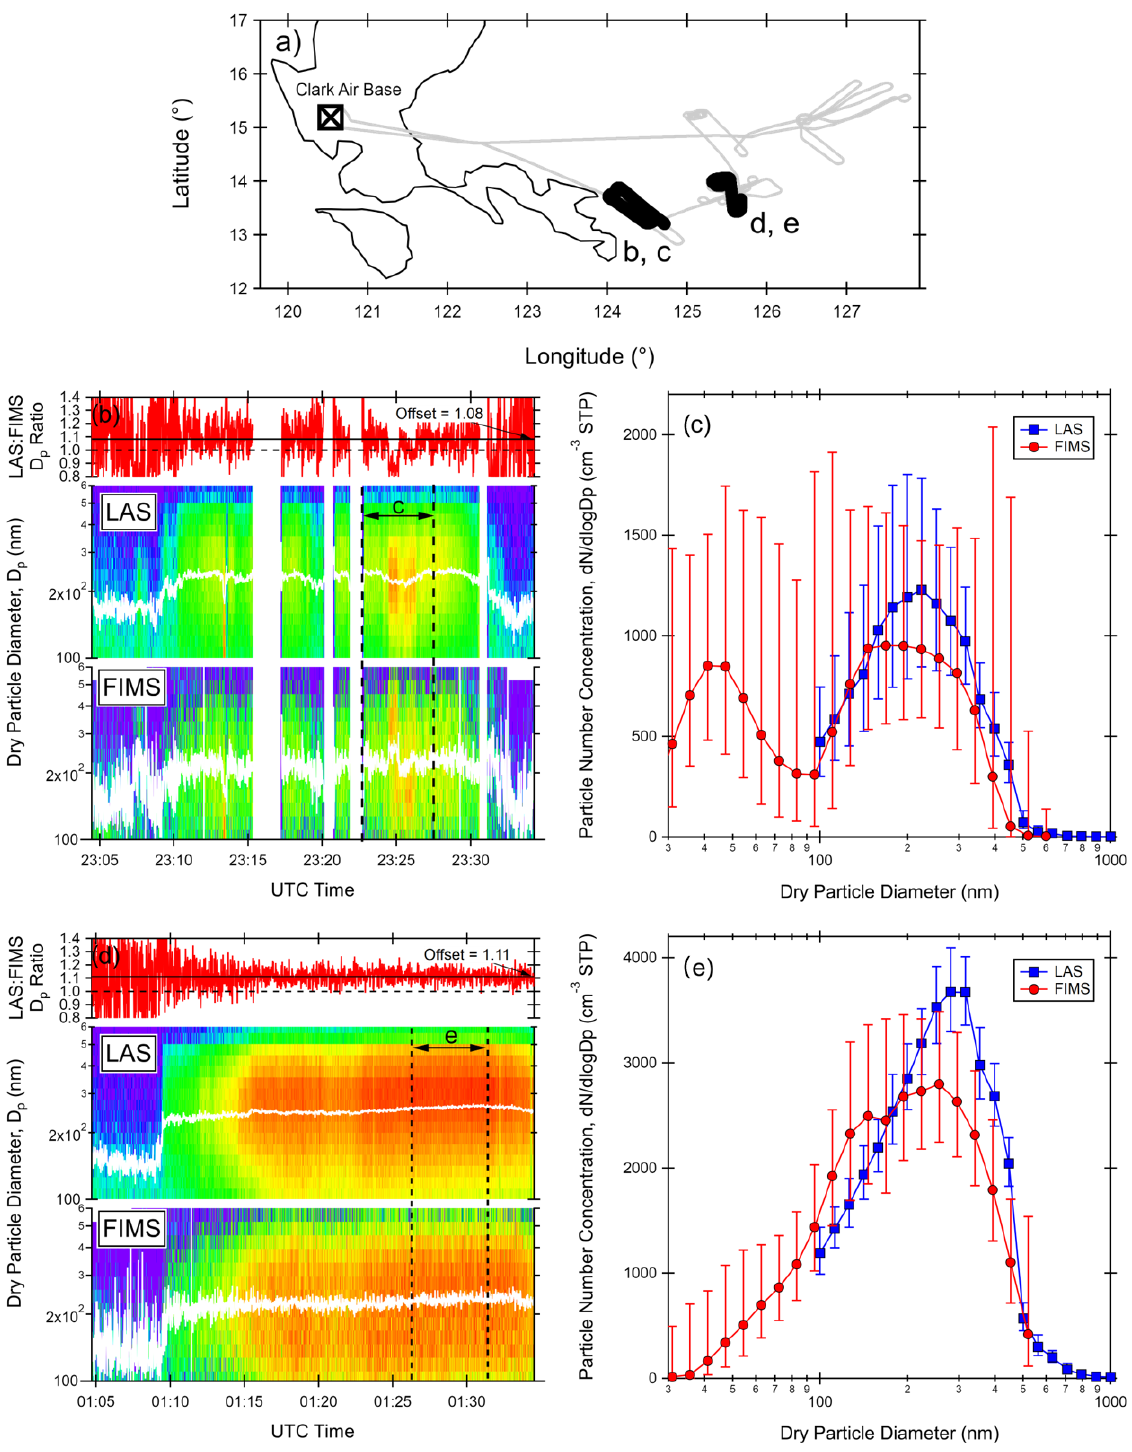
Figure 12. Comparison of the LAS and FIMS aerosol accumulation-mode size distributions for aged biomass burning plumes encountered during CAMP 2 Ex research flight on 16–17 September 2019 east of the Philippines. Panel (a) shows the flight track in gray, with bolded regions indicating the plume encounters. Panels (b) and (d) show the size distribution time series for each instrument with the white trace denoting the count mean diameter (CMD) of the size distribution. Also shown is the ratio of the CMDs for the LAS and FIMS. Panels (c) and (e) are the geometric mean (1 geometric standard deviation) of the aerosol size distributions for level flight legs within the most intense portion of the plume intercept (denoted by the vertical dashed lines in panels b and d ). Reported sizes are for dry particles (RH <